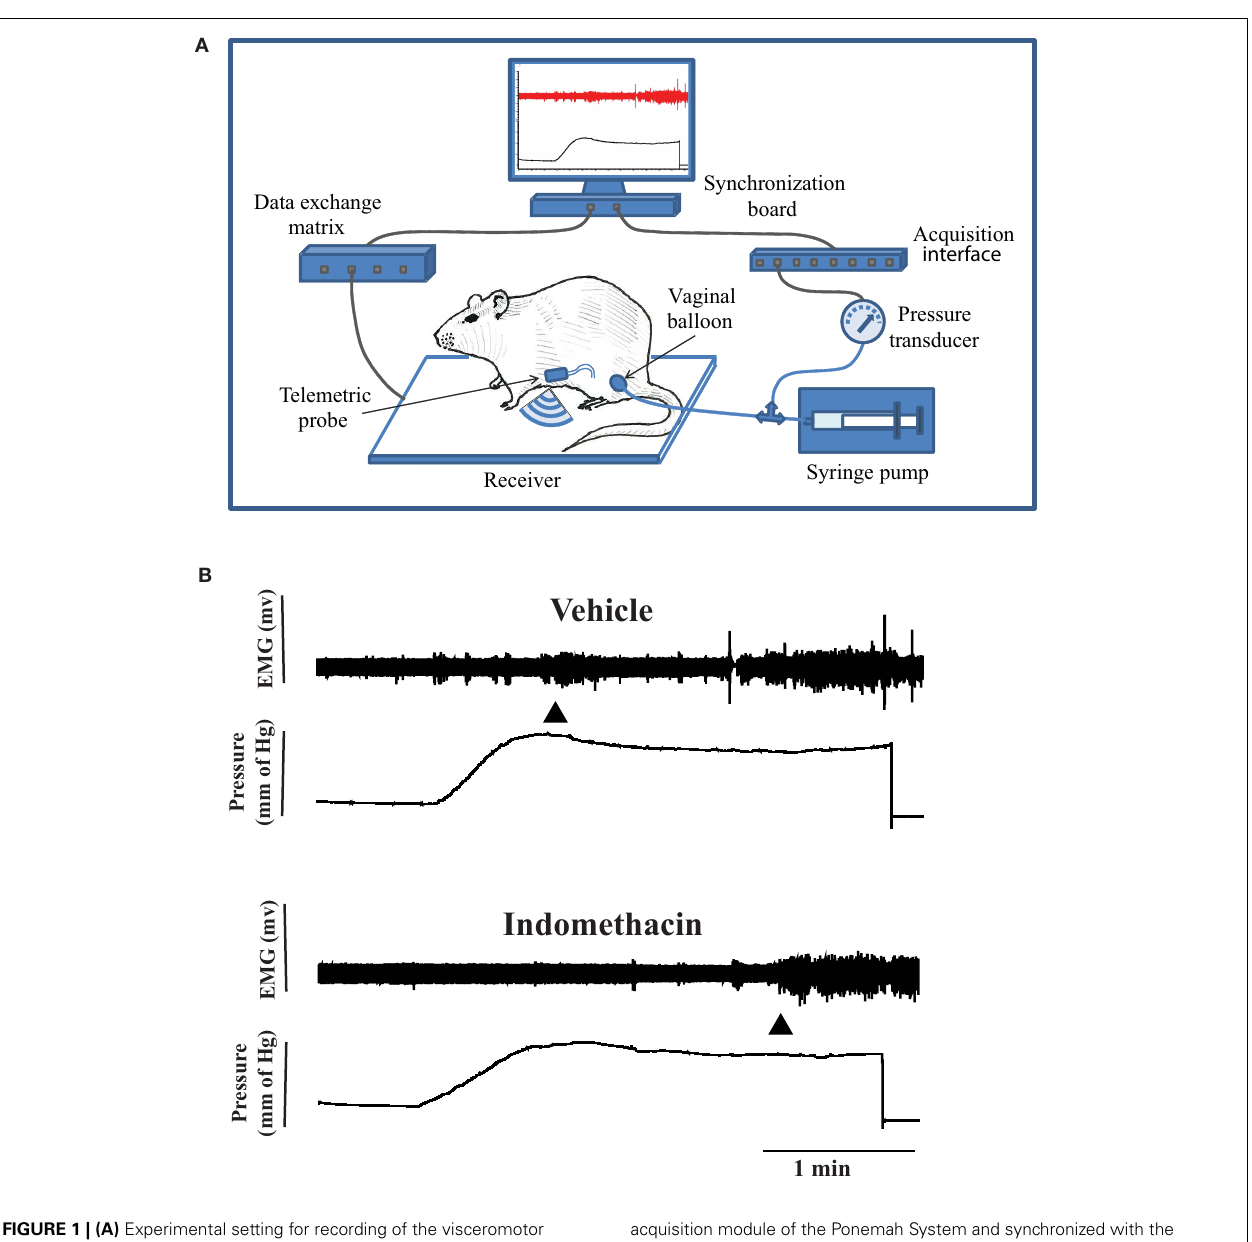
FIGURE 1 | (A) Experimental setting for recording of the visceromotor response (VMR) to vaginal stimulation with the PonemahTelemetric System (DSI, St. Paul, MN, USA). Pressure in the vaginal balloon was generated by an infusion pump.The EMG signal from the electrode implanted in the abdominal muscle was converted into radio signals by the telemetric probe and transmitted to a receiver connected to the